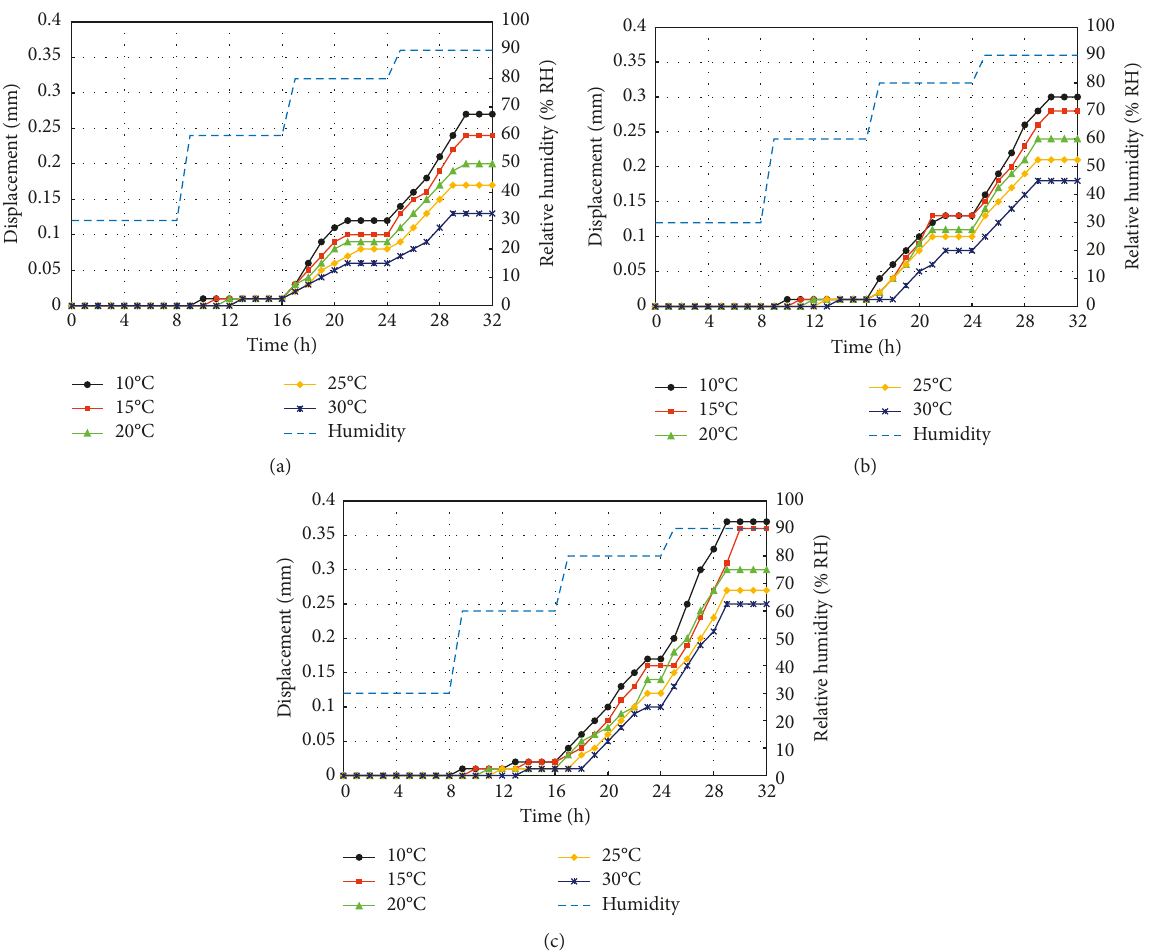
Figure 5: Displacement curve of different salinity of sodium sulfate saline soil under the RH. (a) 2% salinity; (b) 3% salinity; (c) 5%